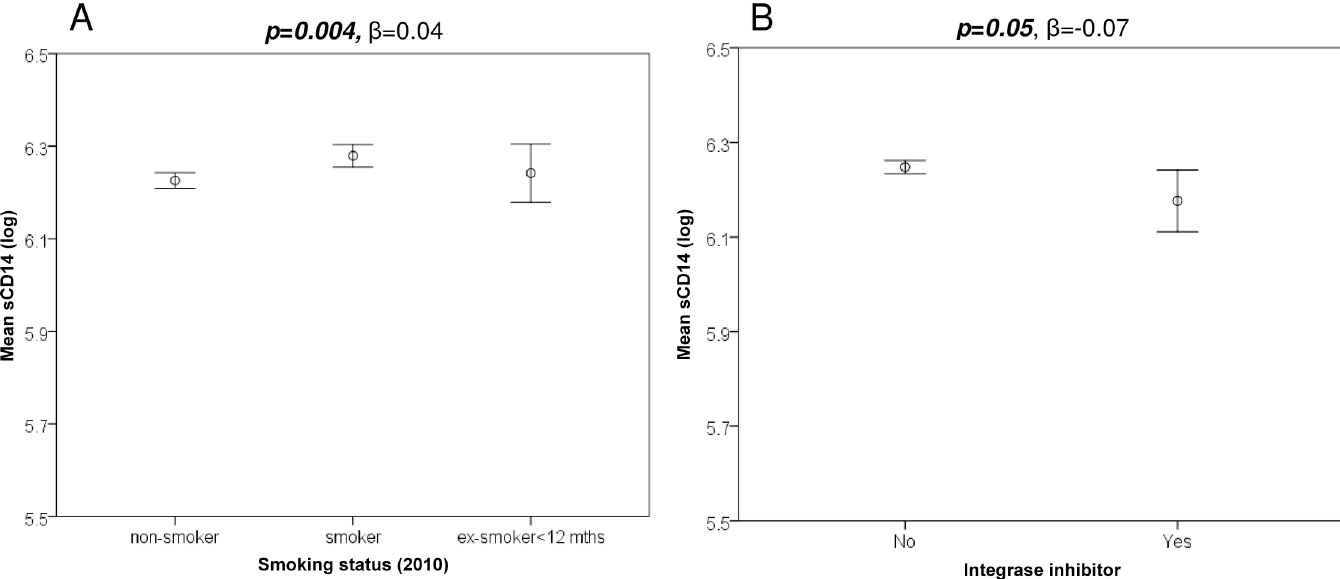
Fig 2. There was a significantly strong correlation between sCD14 and smoking where HIV-1 smokers have higher sCD14 levels than HIV-1 non- smokers while patients on an integrase inhibitor had significantly lower sCD14 levels than patients on an alternative